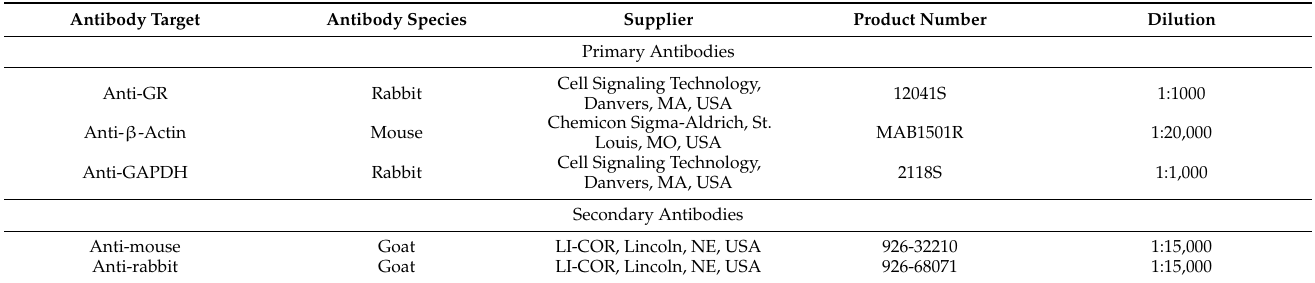
Table 1. List of antibodies used to assess GR stability in UBE3A KO HEK 293T